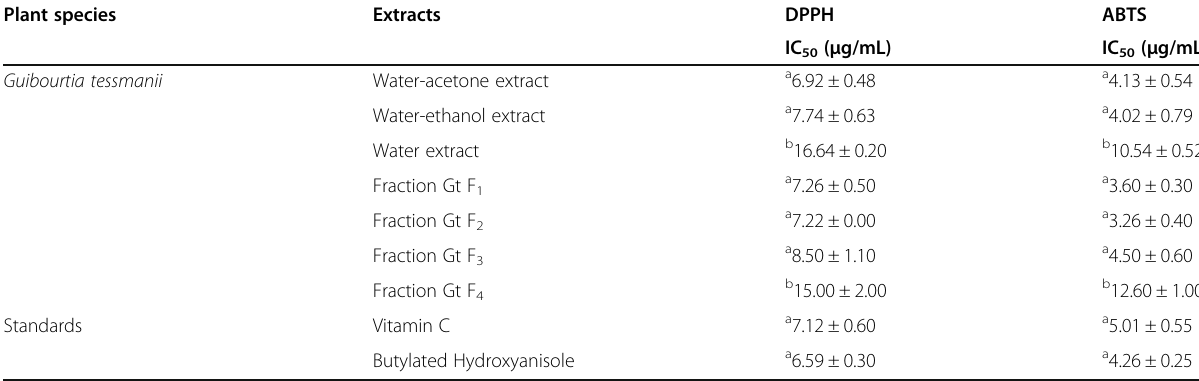
In each column, the assigned values of different alphabetic letters (a, b) indicate significantly different yields ( P